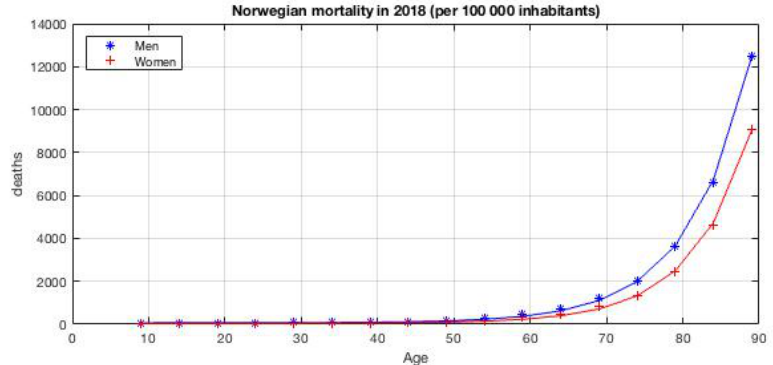
Figure 2. Joint plot of the mortality data given in Table 1, together with the fitted curve using the Gompertz–Makeham law of